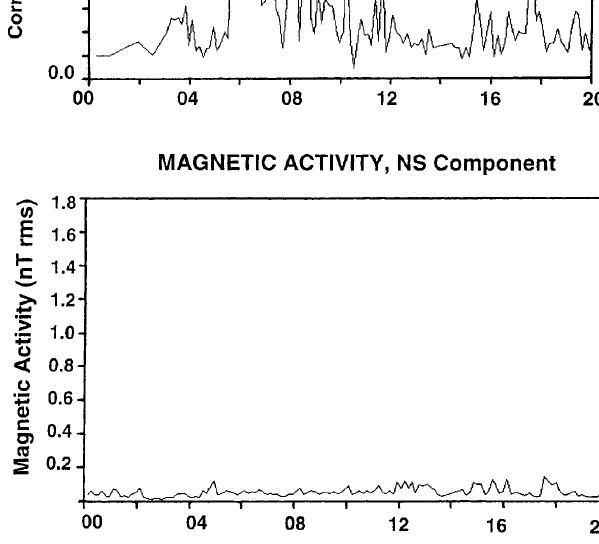
Fig. 5. As for Fig. 4, for 20 October 1991; K